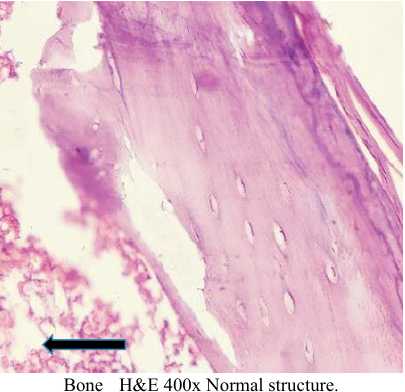
Bone H&E 400x Normal Fig. 9. Histopathology of decalcified bone of group 9 (Punica in Diab.).